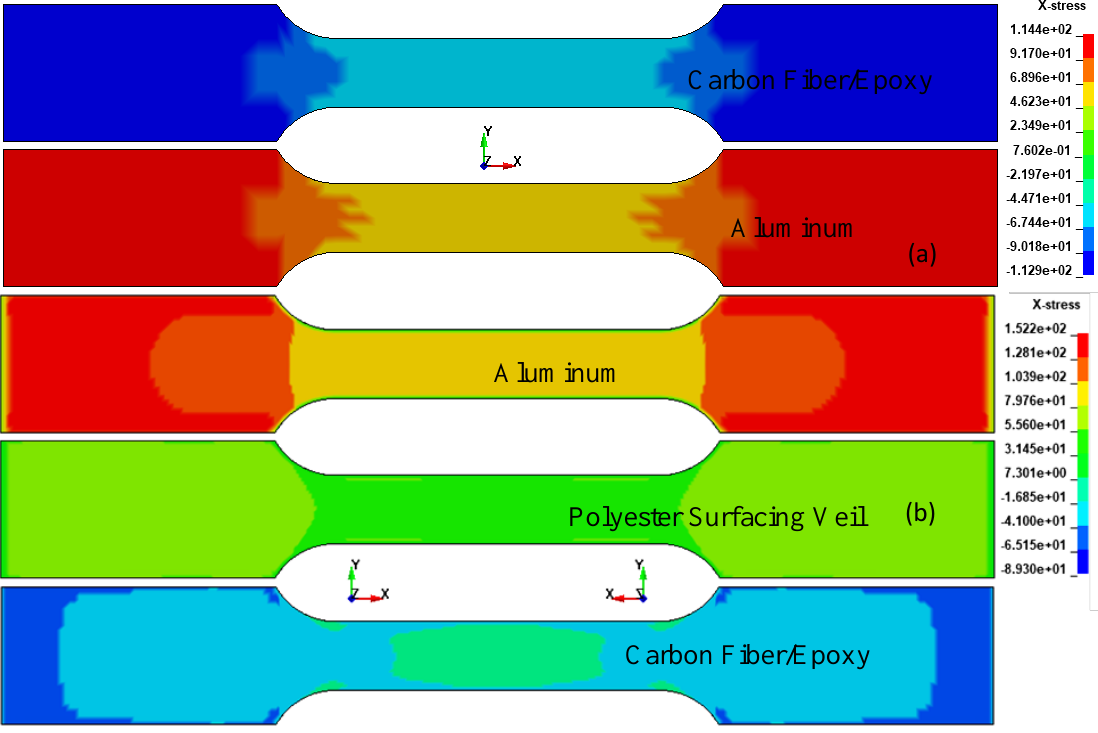
Figure 23. X stress plots for residual stresses; ( a ) CARALL-B, ( b ) CARALL-B with veil layers.